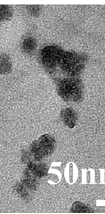
( d ) PA11/1.5% SiO 2 , ( e ) PA11/2.0% SiO 2 .